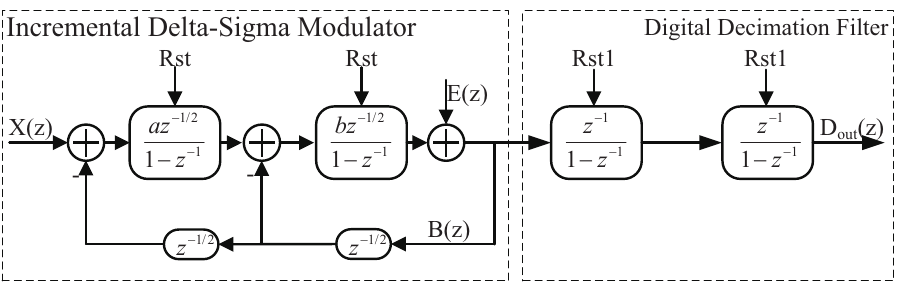
Figure 3. System block diagram of a second-order incremental ∆Σ